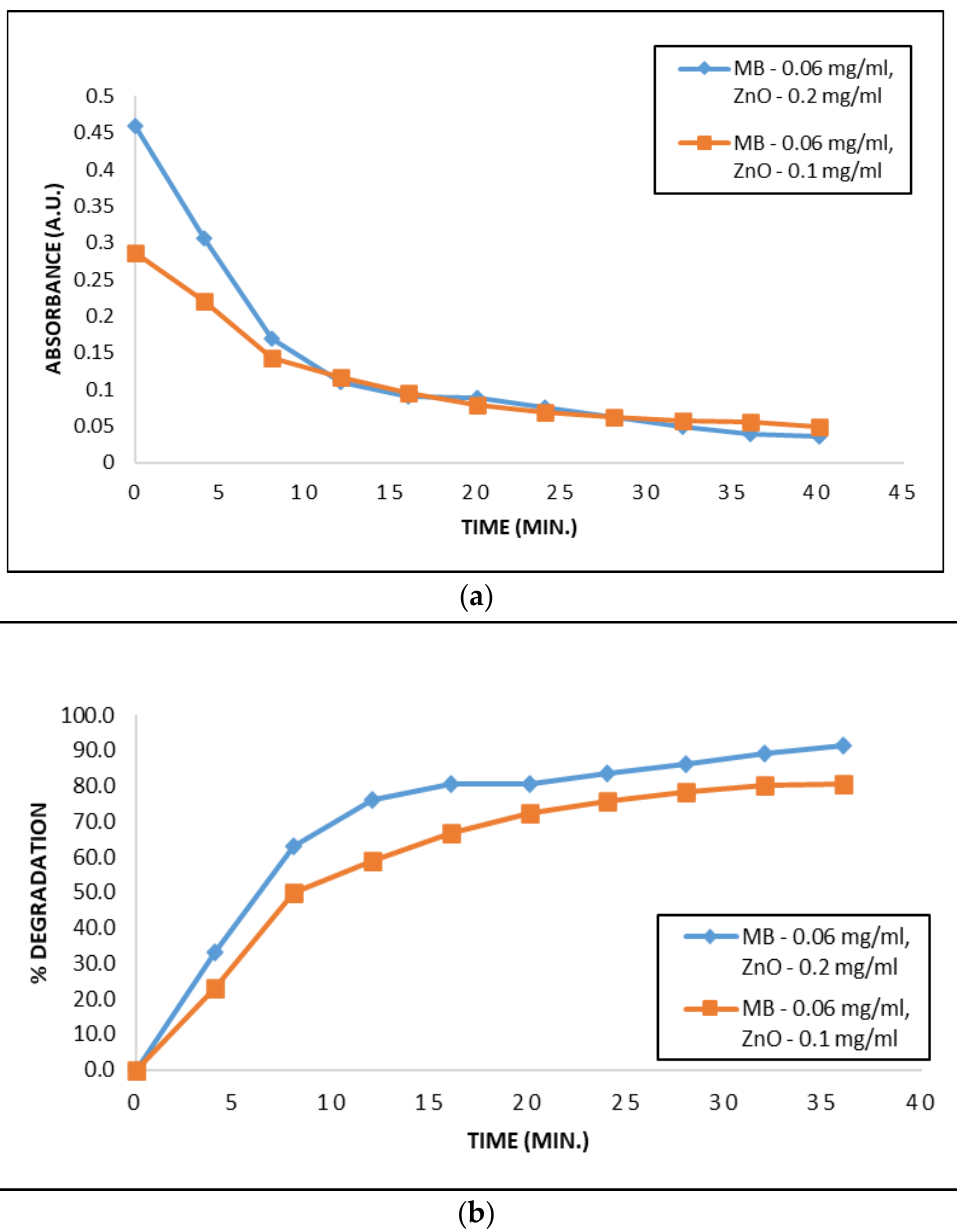
Figure 6. Graph showing the photocatalytic degradation of the model pollutant MB at 0.06 mg/mL with varying ZnO nanoparticle concentration ( a ) Absorption ( b ) %degradation.